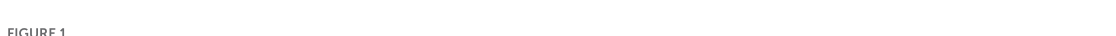
FIGURE1 (D) Quantitative PCR for a number of glial transcripts and transcripts for retinal ganglion cells ( Rbpms ), microglia ( Iba1 ), and oligodendrocytes ( Mbp ) was used to further characterize the ONH astrocytes. Rbpms , Iba1 , and Mbp were not detected in mRNA isolated from control or stretched ONH astrocytes (ND). There were no differences in transcripts for Gfap , Slc1a3 (glutamate-aspartate transporter), Glud1 (glutamate dehydrogenase-1), and Glul (glutamine synthetase). There were significant differences in the Gja1 transcript levels, with stretched ONH astrocytes showing greater fold change as compared to control (* p = 0.0152, n = 3). Gja1 encodes Connexin-43; n = 3 biological replicates per group. (E) GFAP protein, increased when astrocytes undergo hypertrophic reactivity, did not statistically differ between control and stretched ONH astrocytes; n = 3 biological replicates per group. (F) S100 β protein, also upregulated in reactive astrocytes, did not statistically differ between control and stretched ONH astrocytes; n = 3 biological replicates per